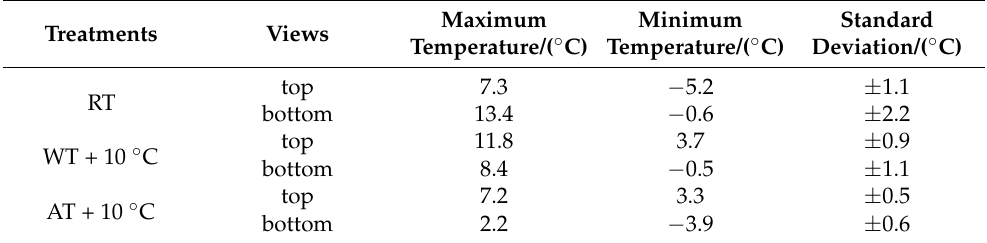
Table 2. Top and bottom surface temperature of salmon after different tempering treatments. (RT: Radio frequency tempering; WT + 10 ◦ C: Water tempering at 10 ± 0.5 ◦ C; AT + 10 ◦ C: Air tempering at 10 ± 1 ◦ C).